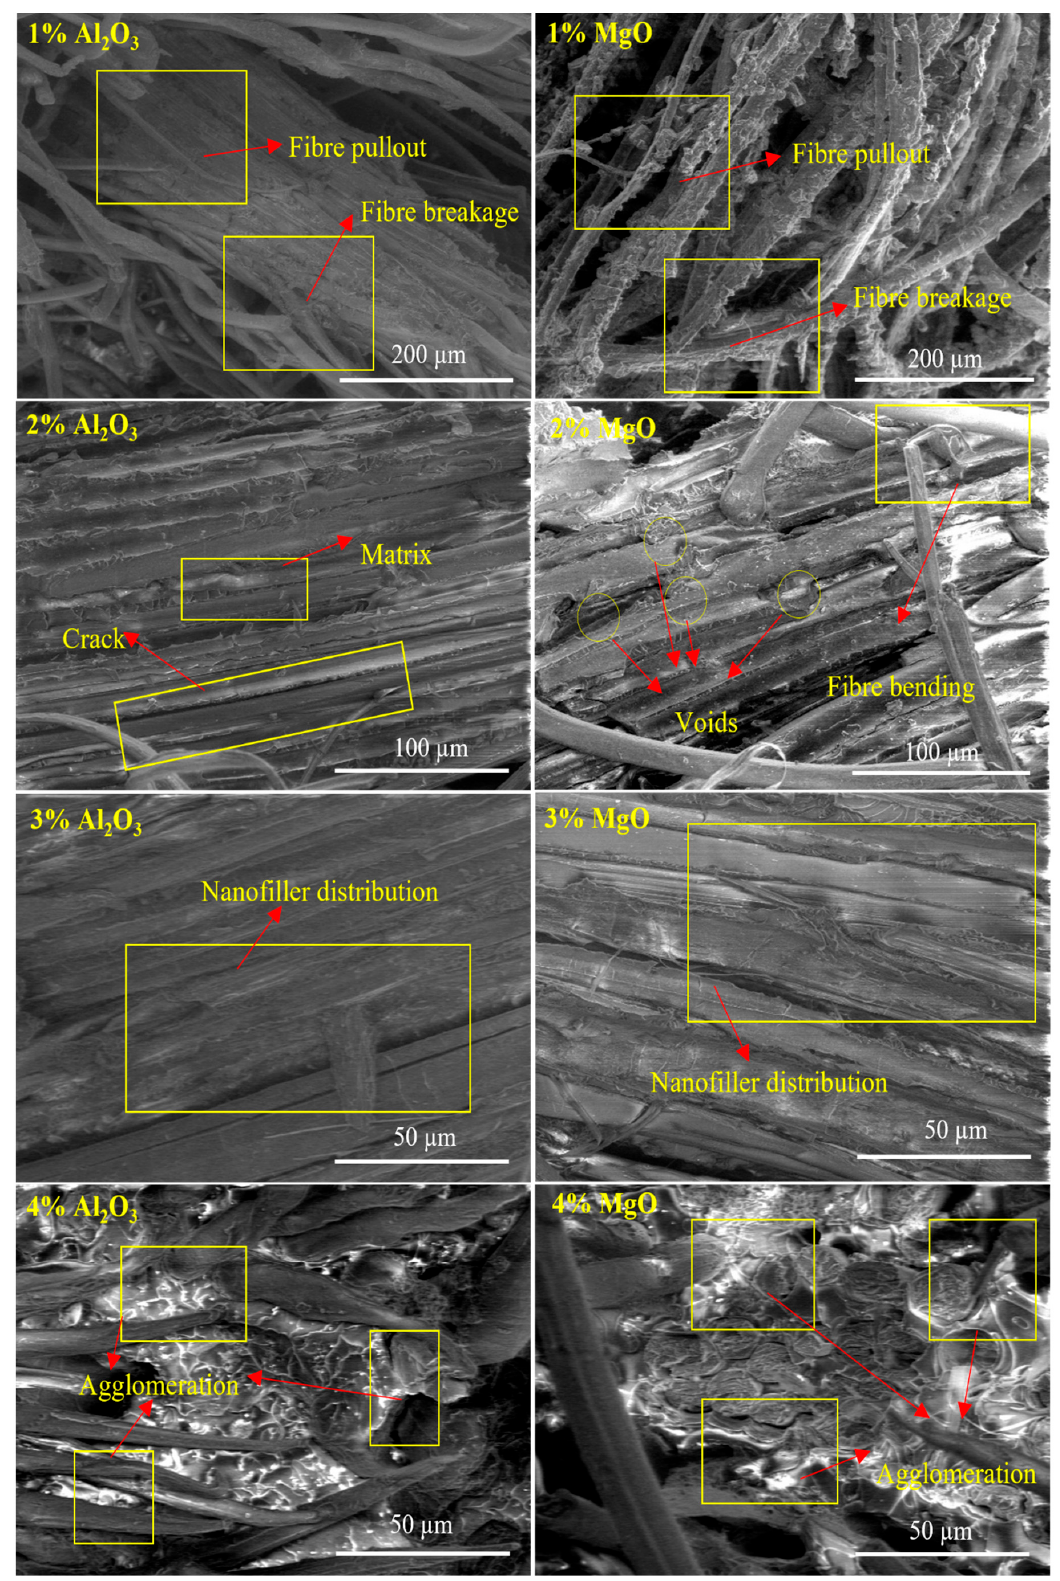
Figure 8. SEM images of untreated biotex flax/PLA reinforced epoxy composite at different percentages of nano-Al 2 O 3 and nano-MgO.